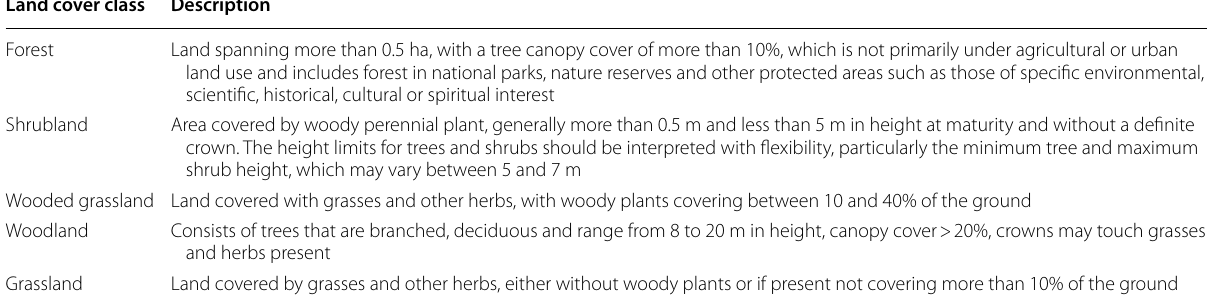
Table 1 Land cover description of Nech Sar National Park Land cover class